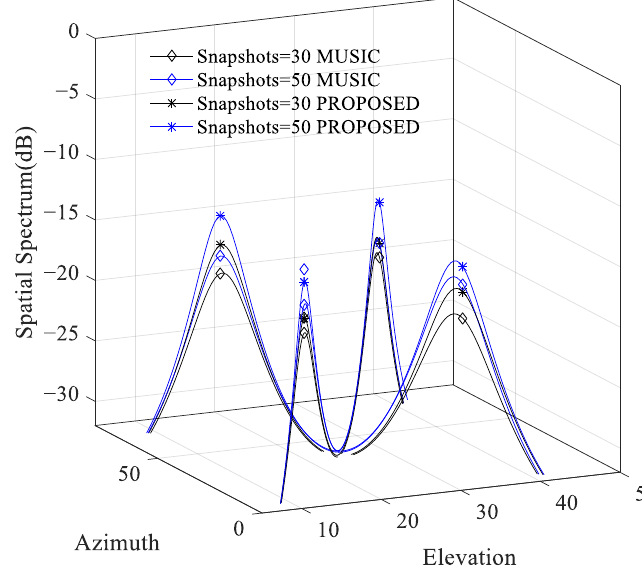
Figure 8. Spatial spectrum versus the number of snapshots.